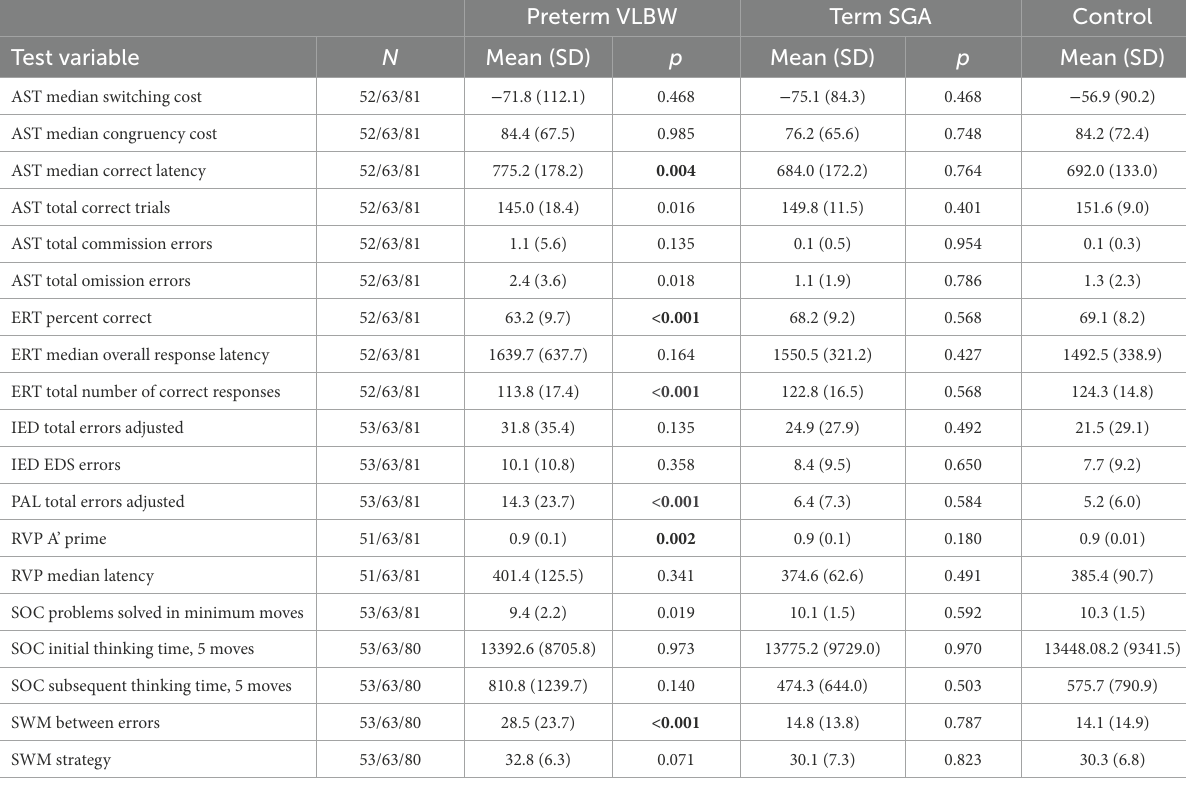
TABLE 3 CANTAB outcome measures at 26 years of age in the three study